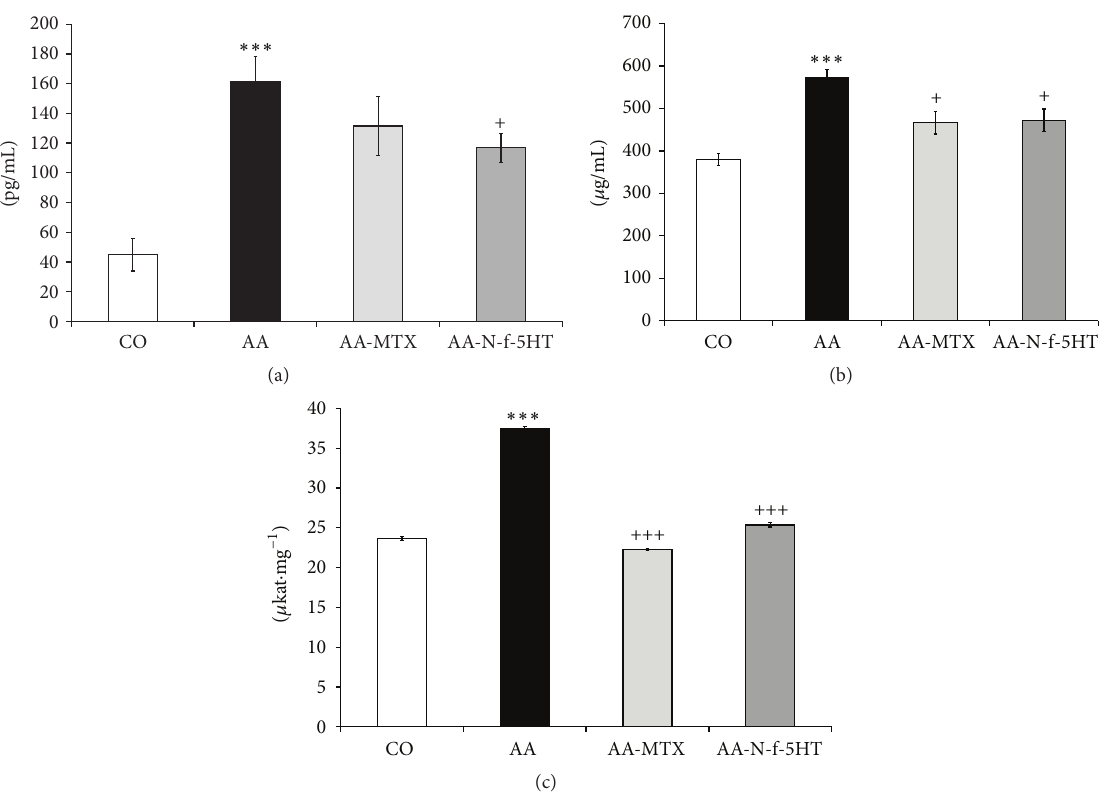
Figure 1: (a) Level of IL-1 𝛽 in plasma in pg/mL measured on day 14. (b) Level of CRP in plasma in 𝜇 g/mL measured on day 28. (c) 12/15-LOX activity in 𝜇 kat ⋅ mg −1 in liver. CO, control group; AA, adjuvant arthritis group; AA-N-f-5HT, adjuvant arthritis group given N- feruloylserotonin; AA-MTX, adjuvant arthritis group given methotrexate. Results are mean ± SEM; 𝑛 = 8 – 10 . The symbols ∗ and + show significant difference: ∗∗∗ 𝑝 < 0.001 versus CO, + 𝑝 < 0.05 versus AA, and +++ 𝑝 < 0.001 versus